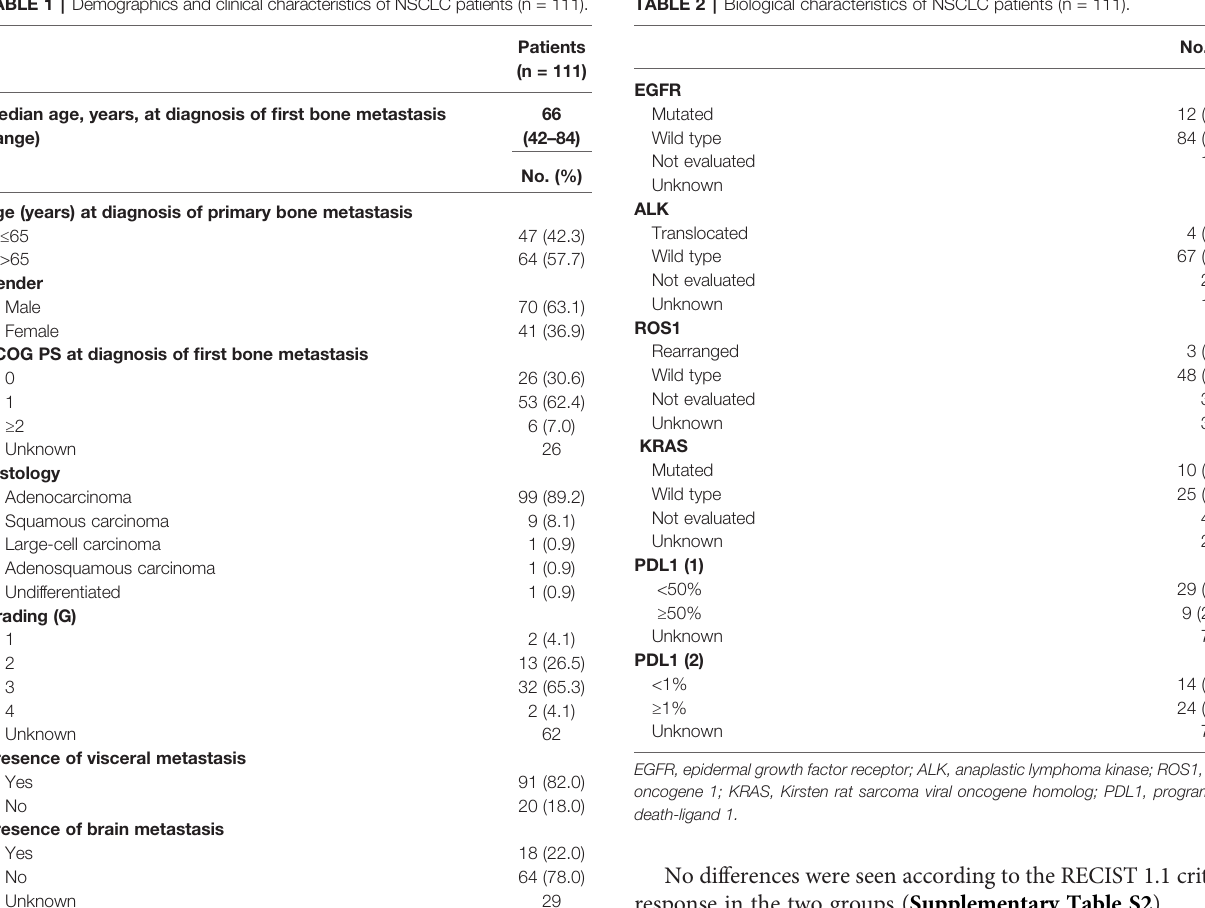
TABLE 1 | Demographics and clinical characteristics of NSCLC patients (n = 111).